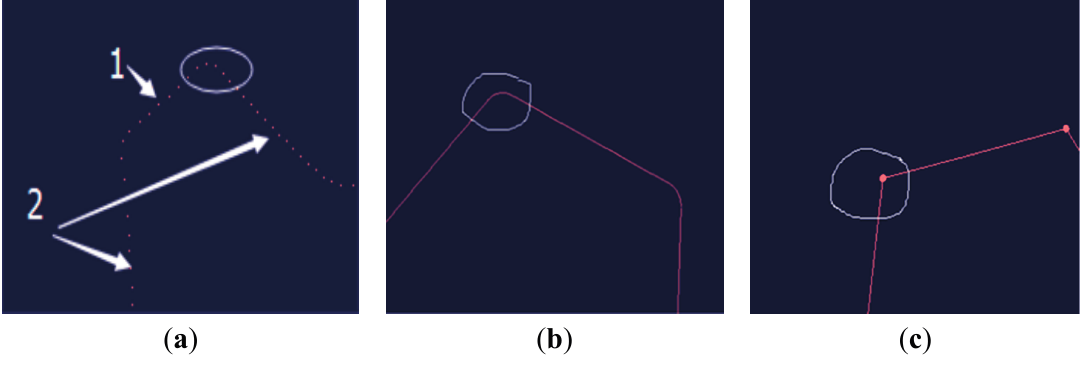
Figure 14. The fitting result comparison: ( a ) The point data; ( b ) The conventional method; ( c ) The proposed